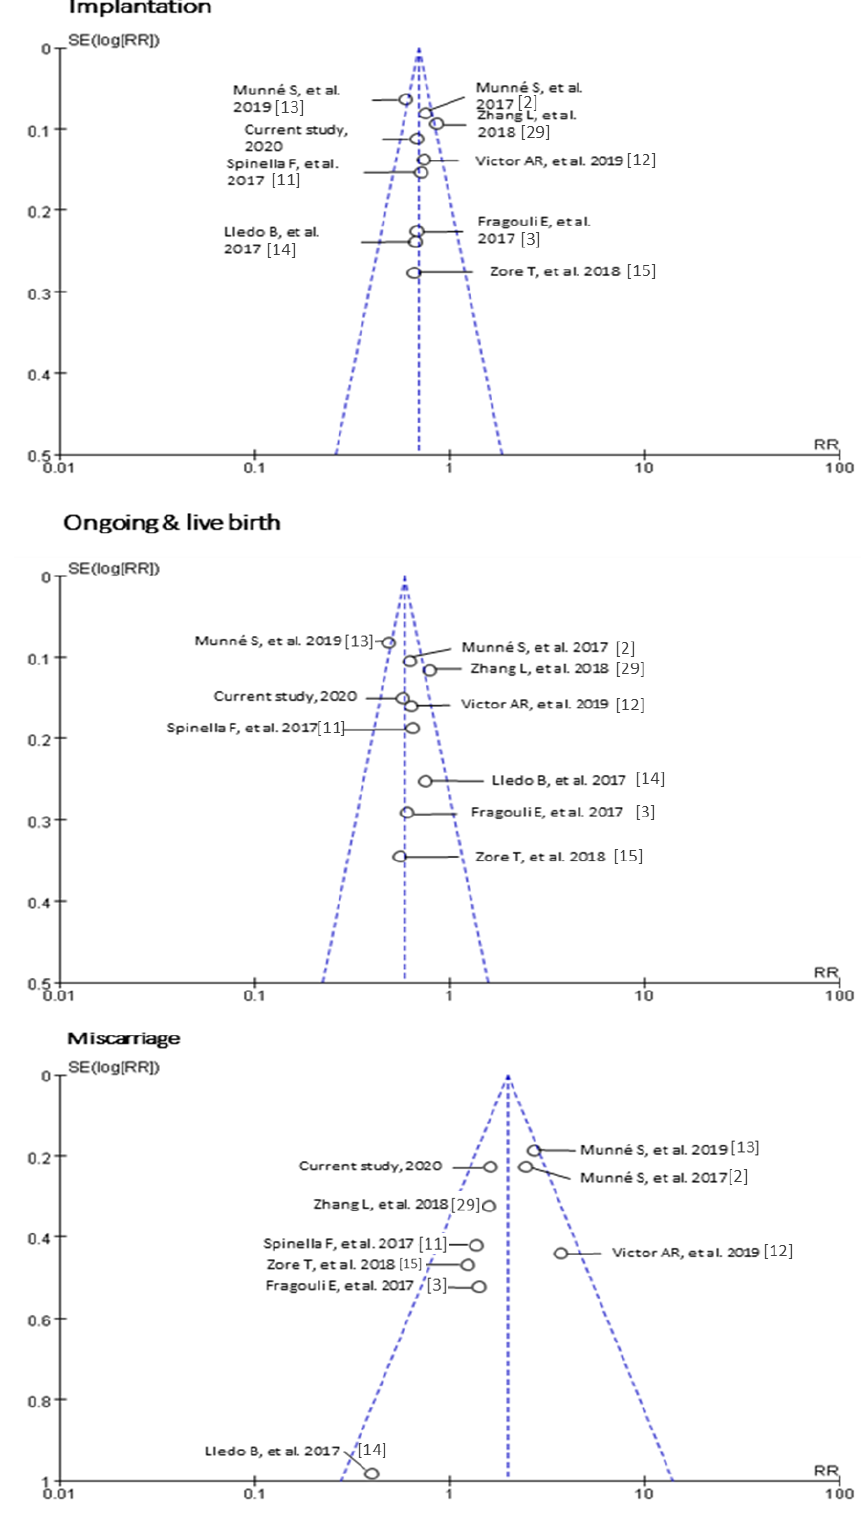
Figure A1. Funnel plot of the nine studies included for meta-analysis.